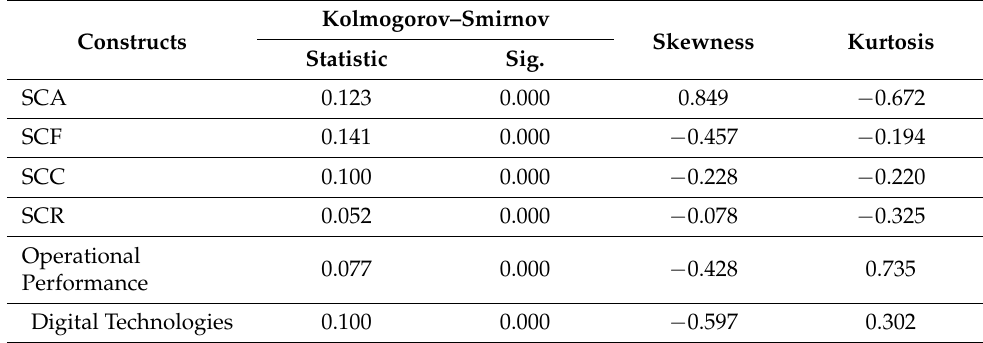
Table 8. Kurtosis and skewness values for study the constructs (N =